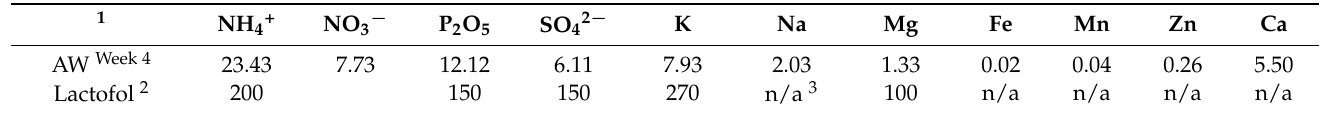
Table 3. Composition of elements in AW at Week